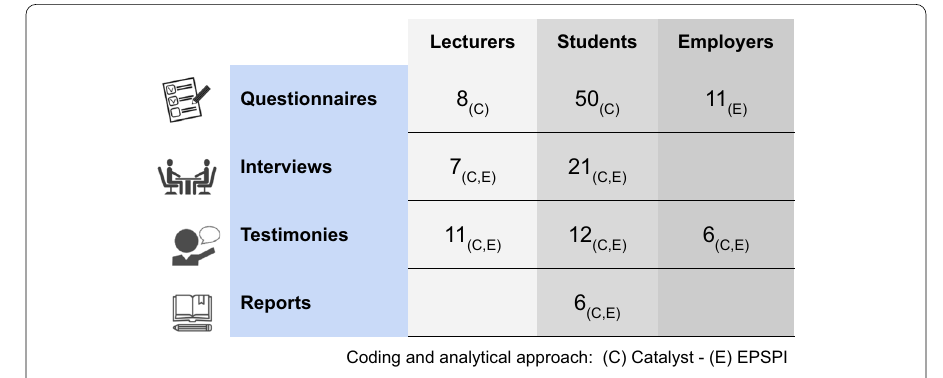
Fig. 2 Research instruments and participants (Source: Authors. EPICA